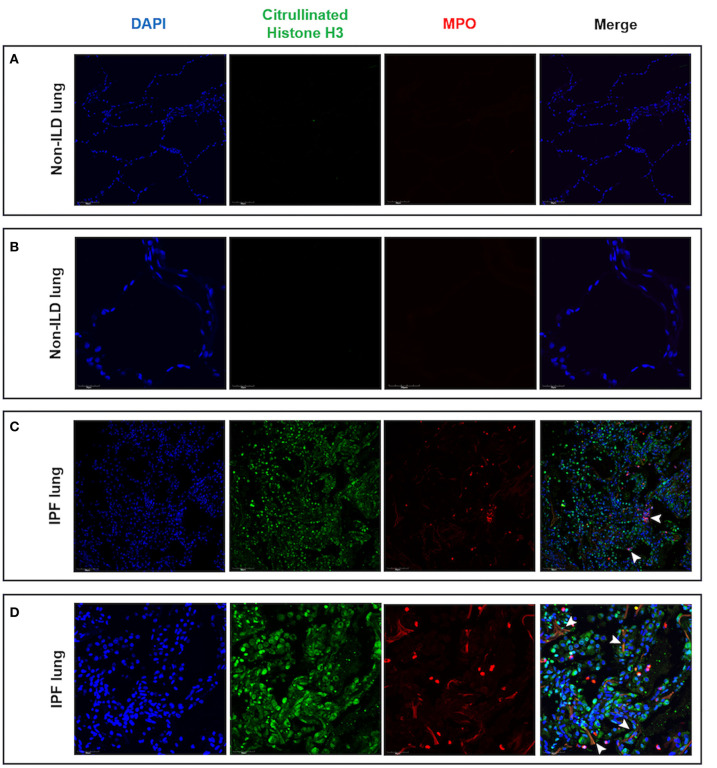
Lung tissue sections from IPF patients contained areas of NET-like structures. Lung tissue from IPF patients and non-ILD control donors was examined for NETs as defined by nuclear DNA (DAPI, blue staining), citrullinated histones (citrullinated histone H3, green staining) and neutrophil-derived proteins (MPO, red staining) by confocal microscopy. (A) Low and (B) high magnification of non-ILD lung displayed normal lung architecture (seen with DAPI staining) and the absence of cellular infiltrates, histone citrullination and MPO staining. In contrast, (C) low and (D) high magnification of IPF lung sections showed areas of extracellular DNA release localized with citrullinated histones and MPO, indicating the presence of NET-like structures in fibrotic lung (white arrowheads). Representative images from two non-ILD control or IPF lungs are shown and the size is denoted by the scale bar. ILD, interstitial lung disease; IPF, idiopathic pulmonary fibrosis.